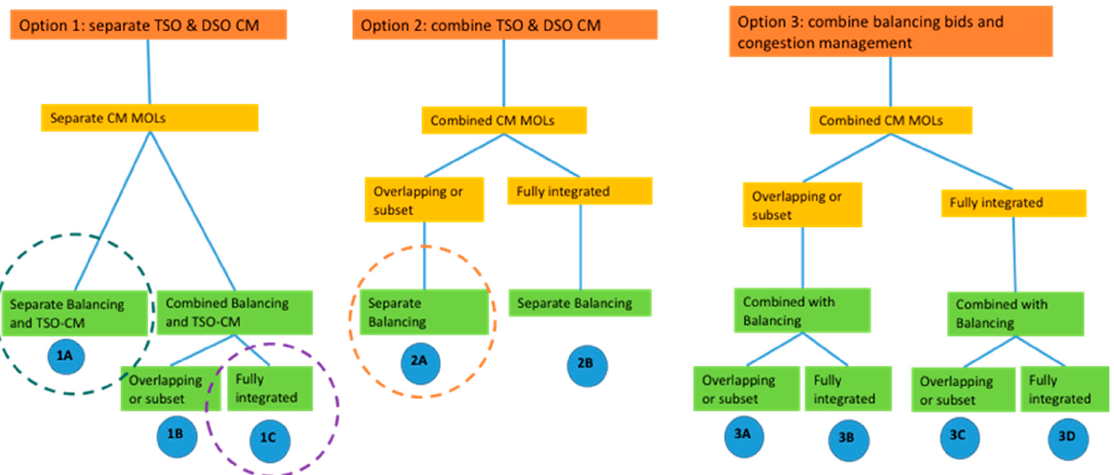
Figure 9. Market design options.